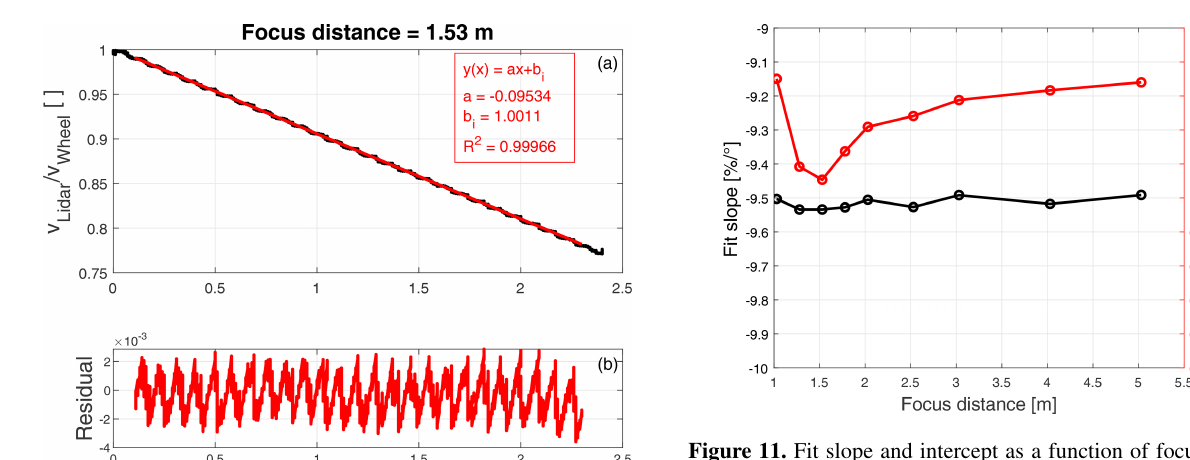
Figure 11. Fit slope and intercept as a function of focus distance. The intercept values show a clear minimum at 1.53m, where the beam width at the wheel is smallest, clearly illustrating the need for compensating these results.